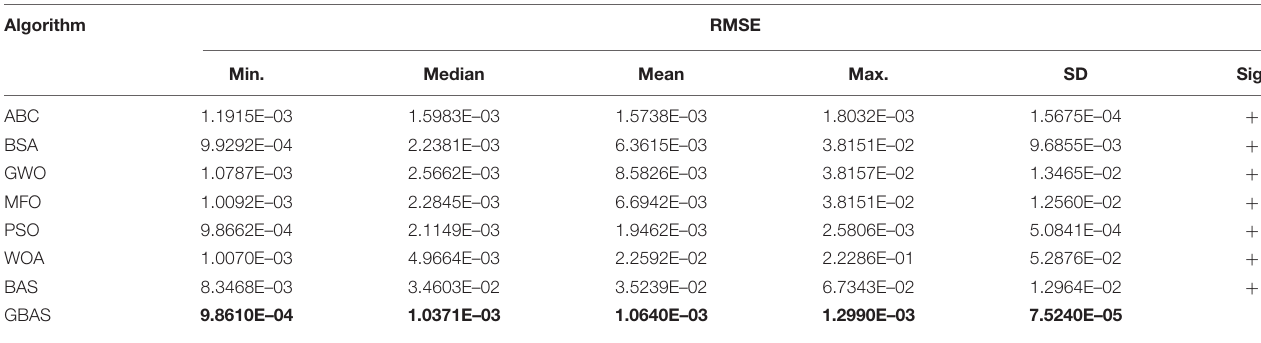
TABLE 6 | Statistical results of root mean square error (RMSE) obtained by various algorithms for single diode model (SDM).